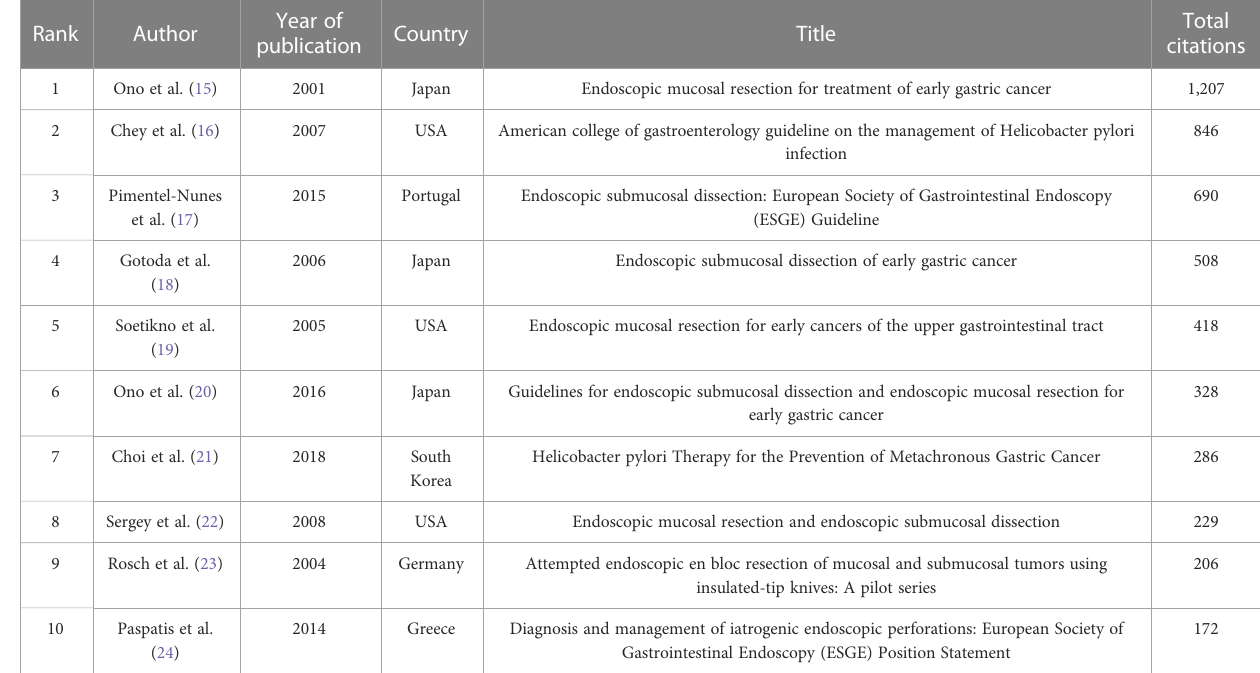
TABLE 1 Top 10 cited papers in endoscope on